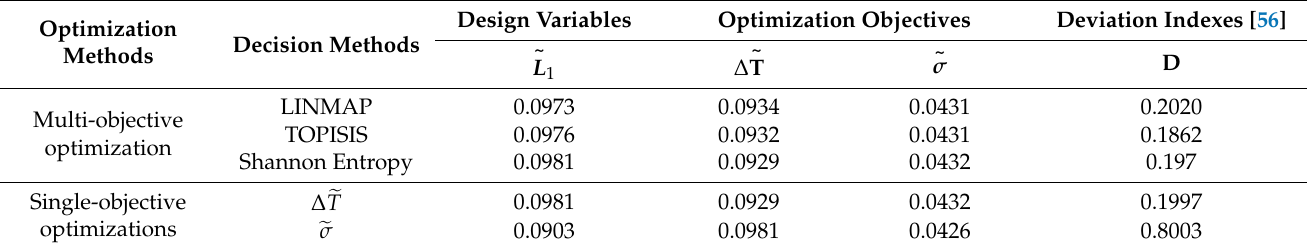
Figure 3. Distribution of (cid:101) L 1 in the Pareto frontiers under single-DOF optimization.  Figure 3. Distribution of 1 L in the Pareto frontiers under single-DOF optimization. Table 1. Optimization results of the square HGB with different objectives under single-DOF  Figure 3. Distribution of 1 L in the Pareto frontiers under single-DOF optimization.